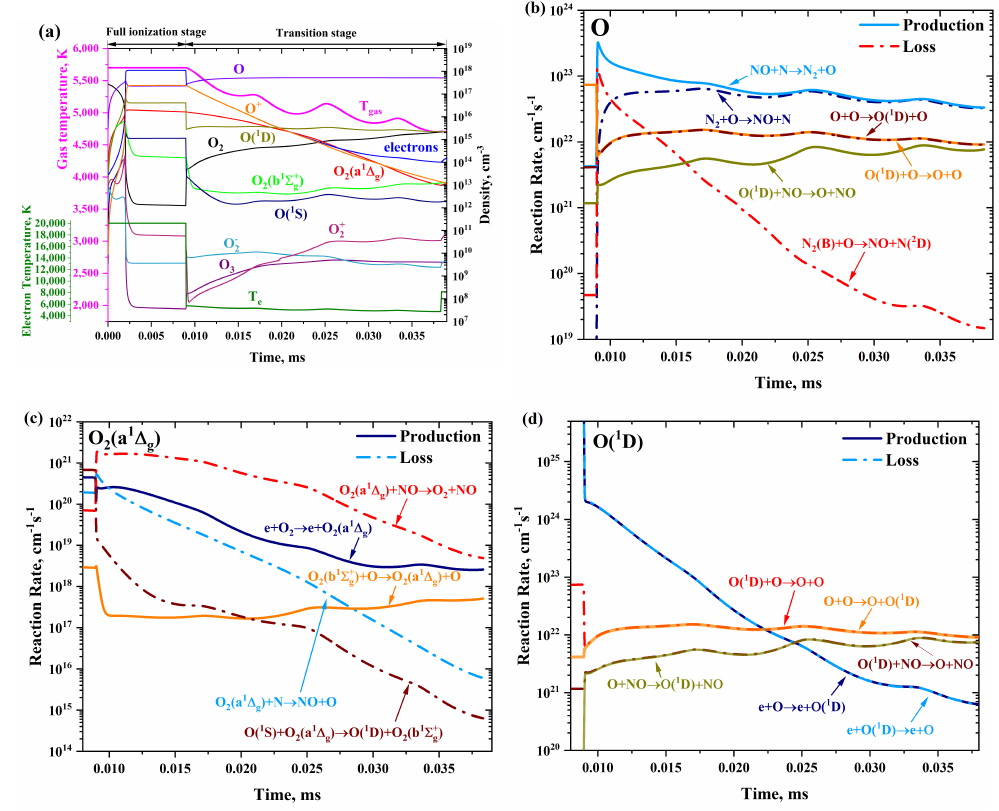
(cid:0) (cid:1) a 1 ∆ g , and ( d ) O ( 1 D )